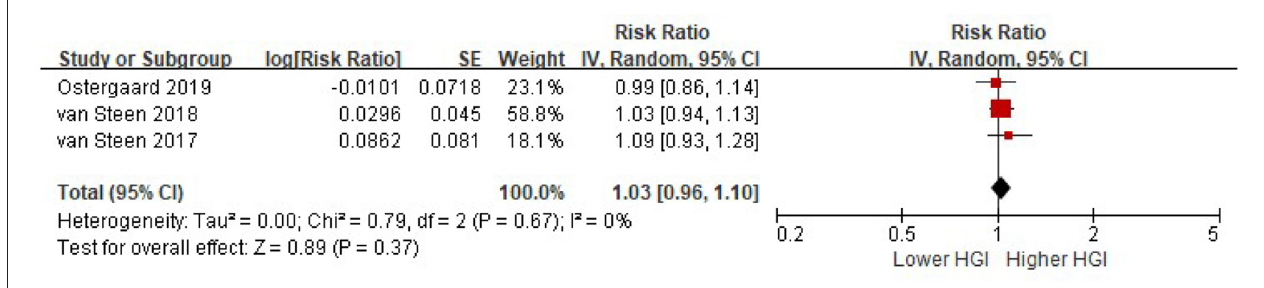
FIGURE 5 | The association between HGI and the risk of all cause mortality further adjusting for HbA1c. Data were presented as the HR and 95% CI of composite CVD for per 1 SD increment of HGI, after adjusting for multiple cardiovascular risk factors and plus HbA1c. CI, confidence interval; HGI, hemoglobin glycation index.